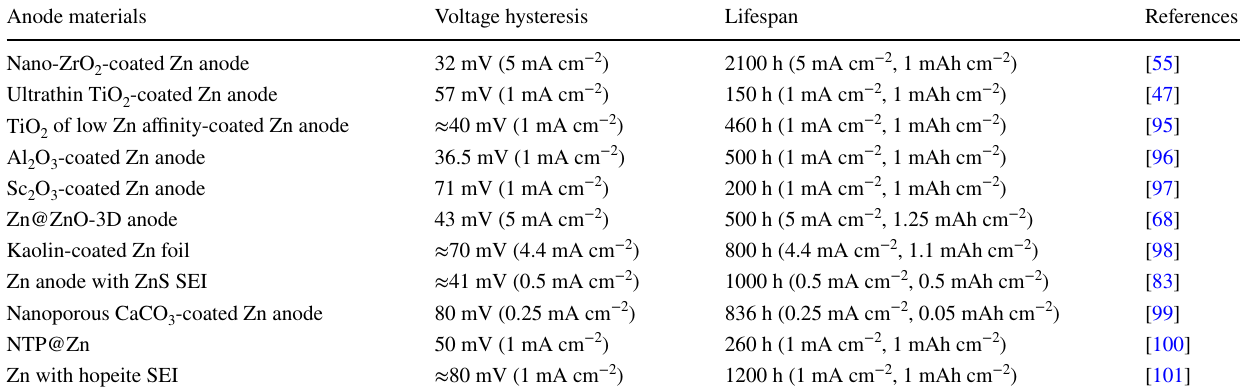
Table 2 Summary of recently reported coatings modification strategies for non-metallic inorganic materials Anode materials Voltage hysteresis